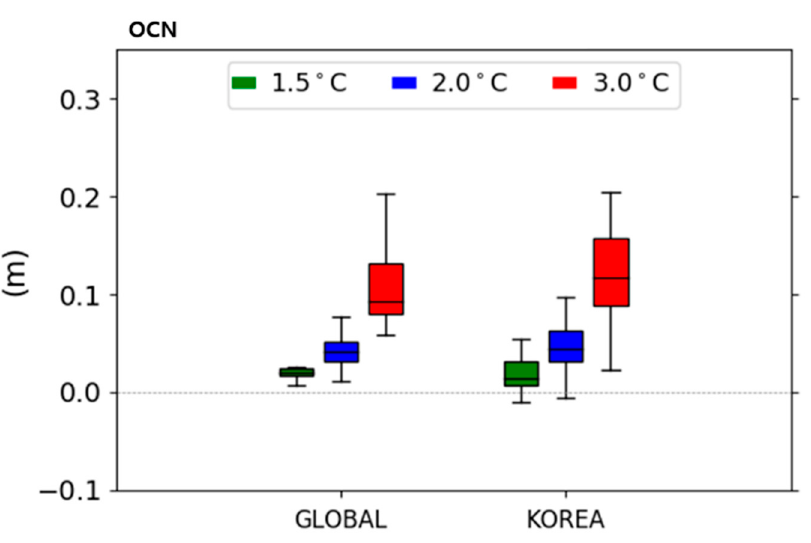
Figure 5. Projected changes in OCN contributions (unit: m) for global and KOR regions relative to the pre-industrial period. Green, blue, and red boxes indicate the T15, T20, and T30 climate targets, respectively.